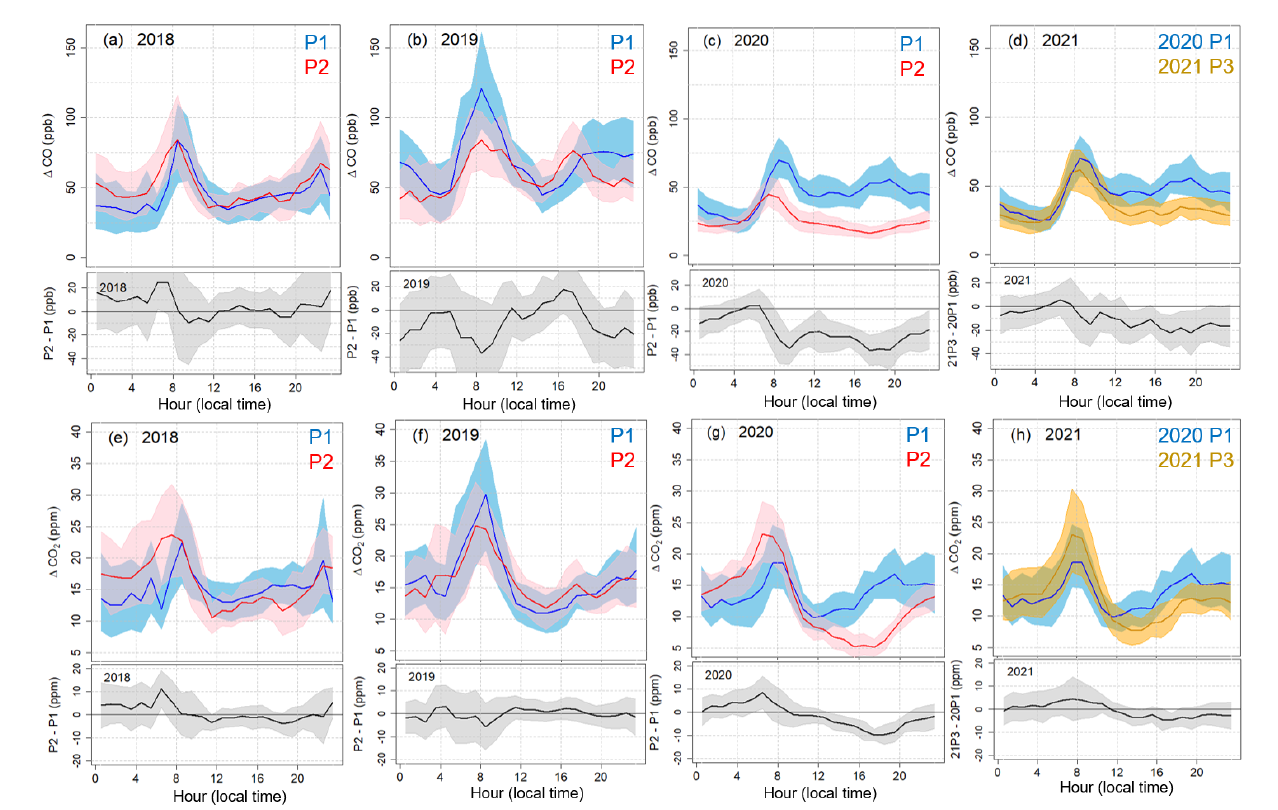
Figure 6. Diurnal variations of ( a – d ) ∆ CO and ( e – h ) ∆ CO 2 on weekdays. Hour is local time. Blue shows results of Period 1, and red shows results of Period 2. Orange in ( d , h ) shows results of 2021 Period 3 (stay-at-home period). Solid lines show the hourly means and the corresponding shades mark the 95% confidence intervals of the means. Black lines show Period 2 minus Period 1 in each year except for 2021. In ( d , h ), the black lines show 2021 Period 3 minus 2020 Period 1. Gray shades are the 95% confidence intervals of the